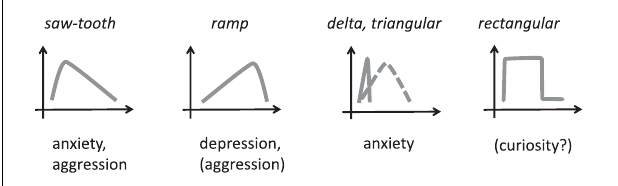
FIGURE 10 | Hypothetical emotion-specific intensity-time profile that could characterize the dynamics of emotions. Saw tooth, ramp, delta/triangular and rectangular functions can be distinguished in context of S-R oriented phenomenological systems analysis. Some emotions appear to fit specifically to these profiles.